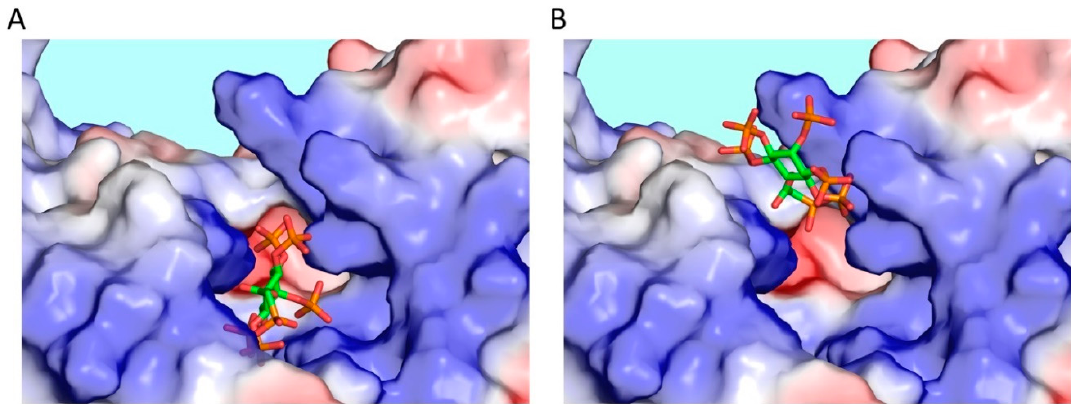
Figure 3. PPIP5K KD has two substrate binding sites. X-ray crystallographic analysis of PPIP5K KD /5- PA-InsP 7 crystal complexes uncovered two mutually exclusive ligand binding sites: ( A ) catalytic pocket; ( B ) substrate capture site. The protein is depicted in surface plot format, in which the intensity of the coloration (blue = positive, red = negative) corresponds to the degree of electrostatic polarization. The ligand is shown in stick form: carbon is green, phosphorous is orange, and oxygen is red.